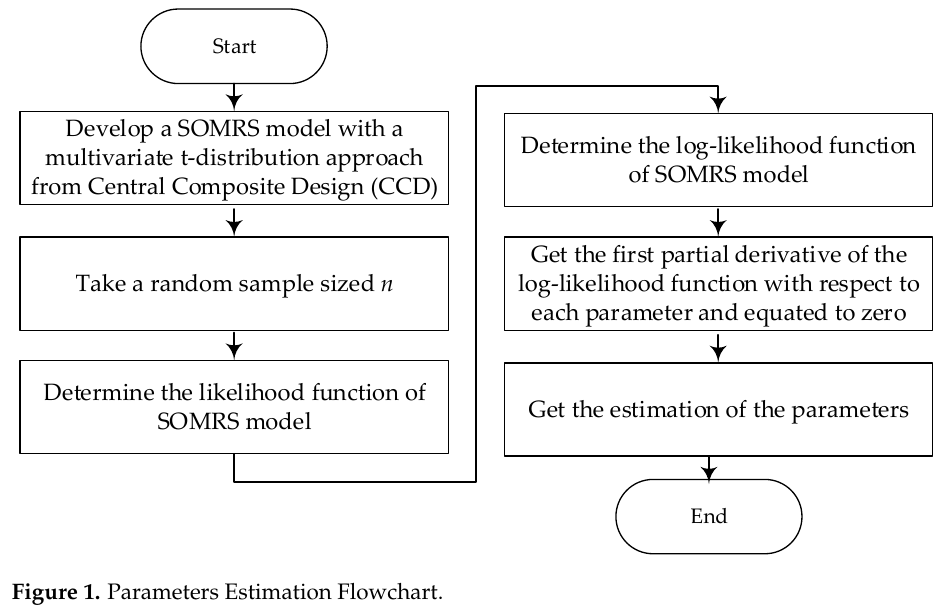
Figure 1. Parameters Estimation Flowchart. The Likelihood Ratio Test (LRT) method to test the SOMRS model parameters simultaneously is shown in Figure 2.